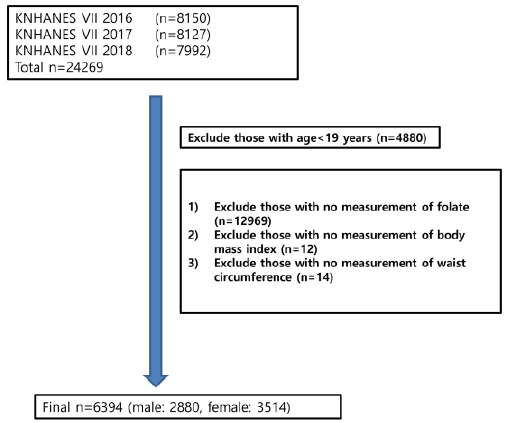
Figure 1. Flow chart showing exclusion procedure of